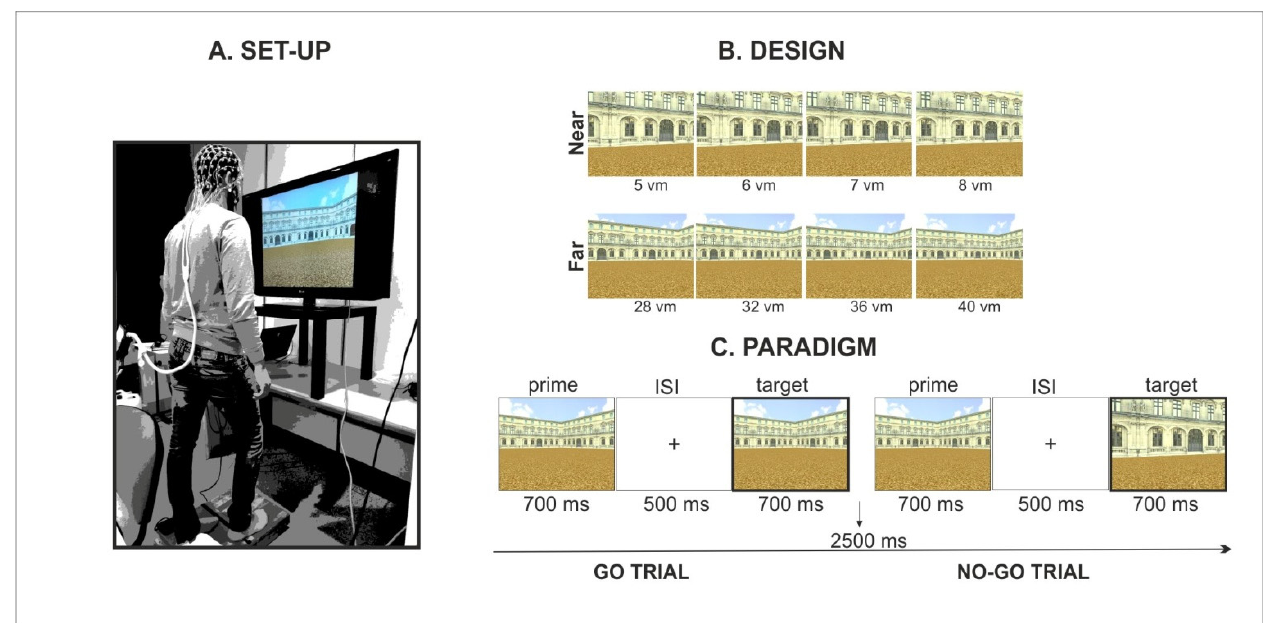
Figure 1. Experimental set up and behavioral paradigm. ( A ). Experimental set-up of wide-field stimulation and foot-pedal response system. ( B ). Experimental design including stimulation conditions of far and near extrapersonal distance (distance is expressed in virtual meters, vm). ( C ). Go/no-go incidental priming paradigm.